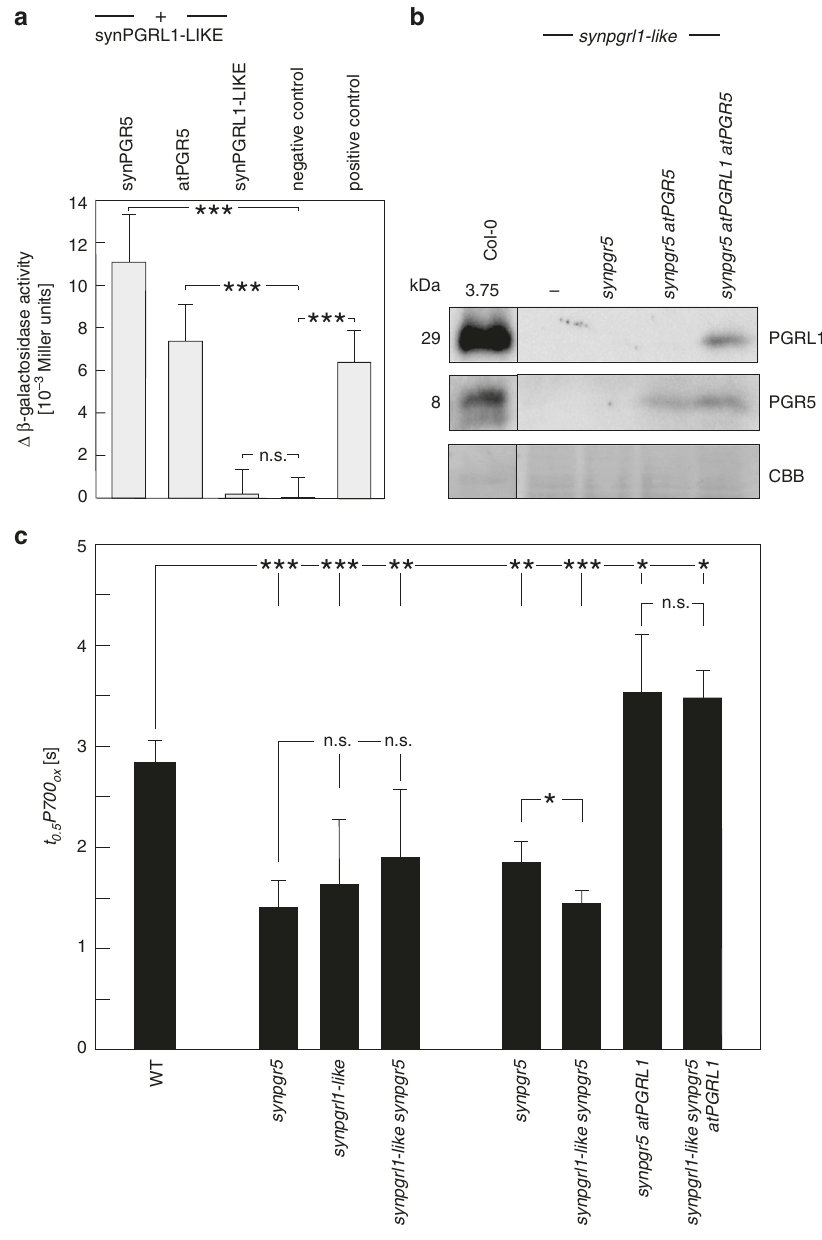
Fig. 3 Cyanobacterial PGRL1-LIKE is functionally analogous to plant PGRL1. a Bacterial two-hybrid analyses. The degree of interaction is indicated by differential β -galactosidase activity (i.e. activity above the baseline activity of the negative control). Known interacting proteins served as positive control, known noninteracting proteins as negative control (see Methods). Error bars correspond to the standard deviation for n = 3 independent experiments and statistically signi fi cant differences with respect to WT or synpgr5 according to Holm-corrected two-sided Student ’ s t -tests are indicated with asterisks ( *** P ≤ 0.001, n.s., not statistically signi fi cant). b Immunoblot detection of atPGRL1 and atPGR5 proteins in various strains of Synechocystis , all of which lack Sll1217/synPGRL1-LIKE ( synpgrl1-like ) and/or synPGR5. Extracts of the synpgrl1-like strain and WT A. thaliana were used as functional controls, and a segment of the Coomassie Brilliant Blue (CBB) stained blot is provided as a loading control. c Effects of the absence of synPGRL1-LIKE on CEF. Average t 0.5 P700 ox values are provided for the Synechocystis strains from panel b , as well as other strains from Fig. 1 as controls. Error bars correspond to the standard deviation for n = 6/6/5/5/4/3/6/4 (order as displayed) independent experiments and statistically signi fi cant differences according to Holm- corrected two-sided Student ’ s t -tests are indicated with asterisks ( * P ≤ 0.05, ** P ≤ 0.01, *** P ≤ 0.001, n.s., not statistically signi fi cant). Bacterial two-hybrid analysis . Protein-protein interactions were determined with bacterioferritin Bfr2 (Slr1890)-Bfd combination, two proteins with known transient interaction in P. aeruginosa 40 , was employed as the positive control. the BACTH (Bacterial Adenylate Cyclase Two-Hybrid System) kit (Euromedex). In this assay, the strength of interactions between pairs of proteins is determined as differential β -galactosidase activity (i.e. activity above the baseline activity of the negative control) and measured as o -nitrophenyl- β -galactoside cleavage. Non- Sequence analysis . Homology searches by local protein sequence alignment interacting protein pairs (the putative transcription factor Sll0149 and bacterioferritin- (pBlast) were conducted using the implementations in the NCBI 41 and Cyano- associated ferredoxin Bfd/Ssl2250) served as negative controls, whereas the Base 42 versions. The CyanoBase pBlast expectation value threshold E was altered to NATURE COMMUNICATIONS| (2019) 10:5299